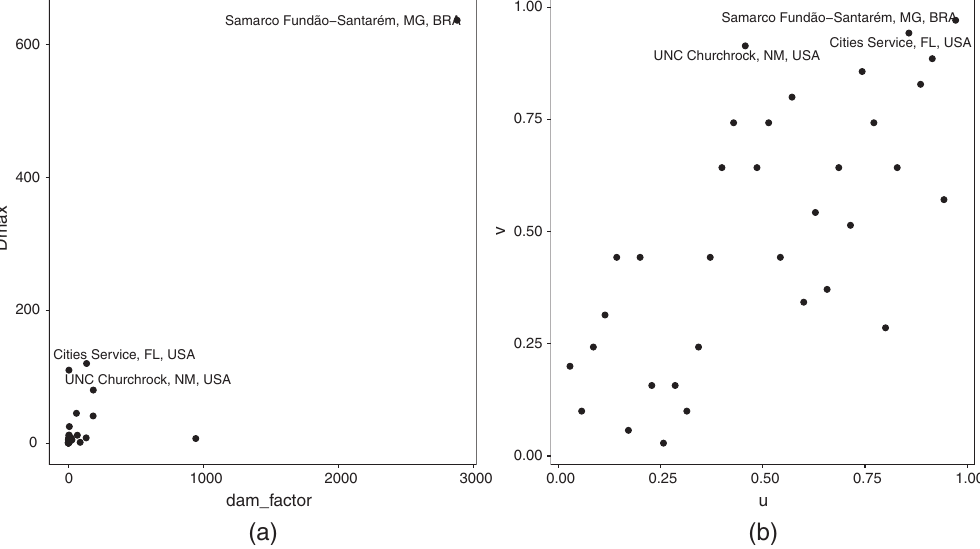
Figure 2. Scatterplot for H (cid:1) V F vs. D max with (a) original observations and (b) observations transformed to [0, 1] by scaling ranks, U vs. V . H in meters (m), D max in kilometres (km).